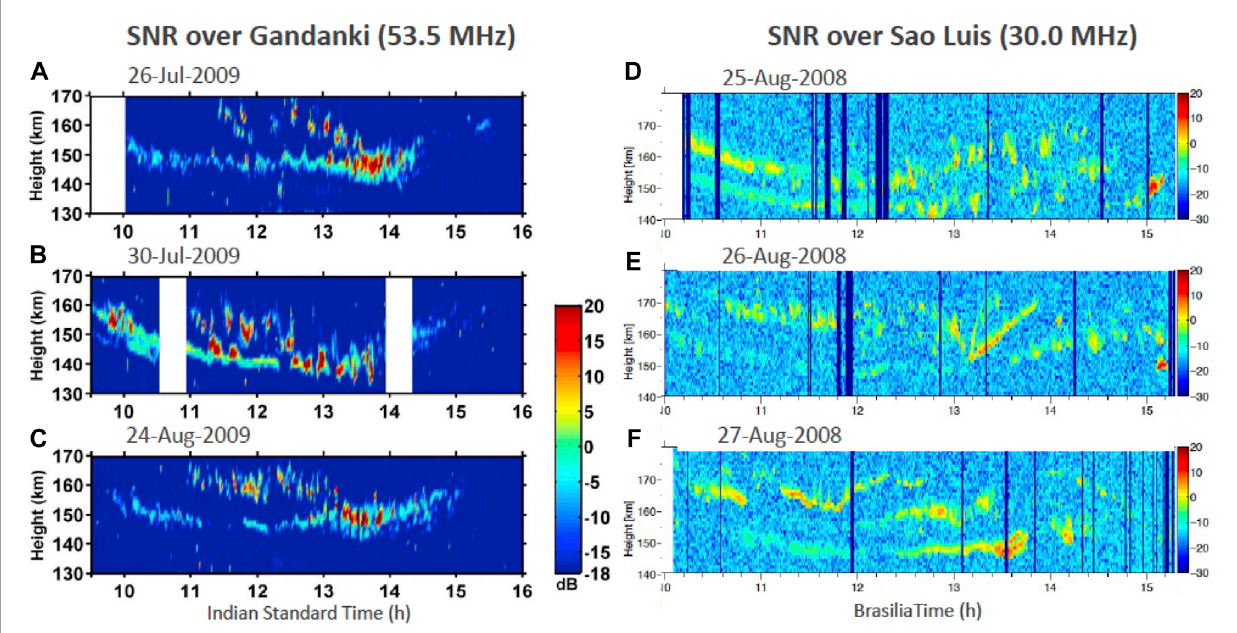
FIGURE 5 Altitude-time SNR plots of 150-km echoes observed at different zenith angles over the Equatorial Atmosphere Radar, Indonesia on 02-February-2008 (from Yokoyama et al., 2009, Figure 3).